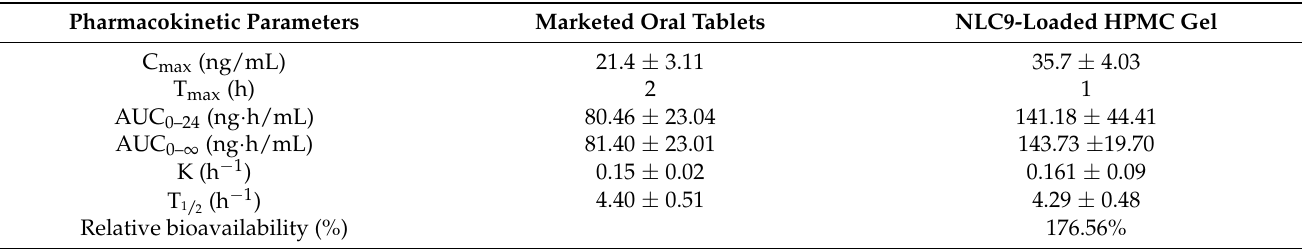
Table 5. Pharmacokinetic parameters of zolmitriptan after transdermal administration of NLC9- loaded HPMC gel in comparison to marketed oral tablets (Zomig ® ) a,b